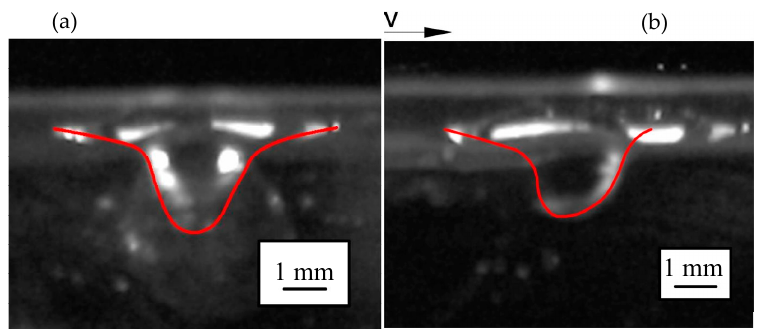
Figure 11. Keyhole in Ga–In–Sn alloy: ( a ) Stationary keyhole; ( b ) Dynamic keyhole.